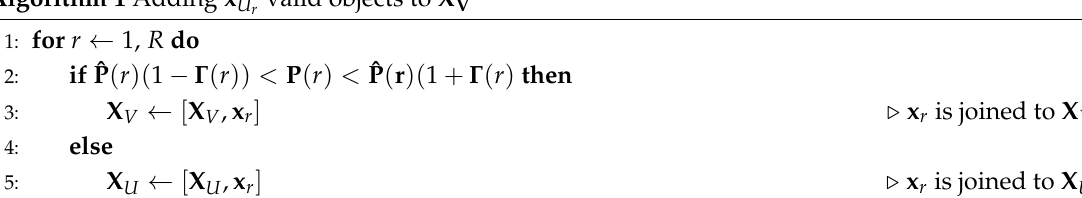
Algorithm 1 Adding x U